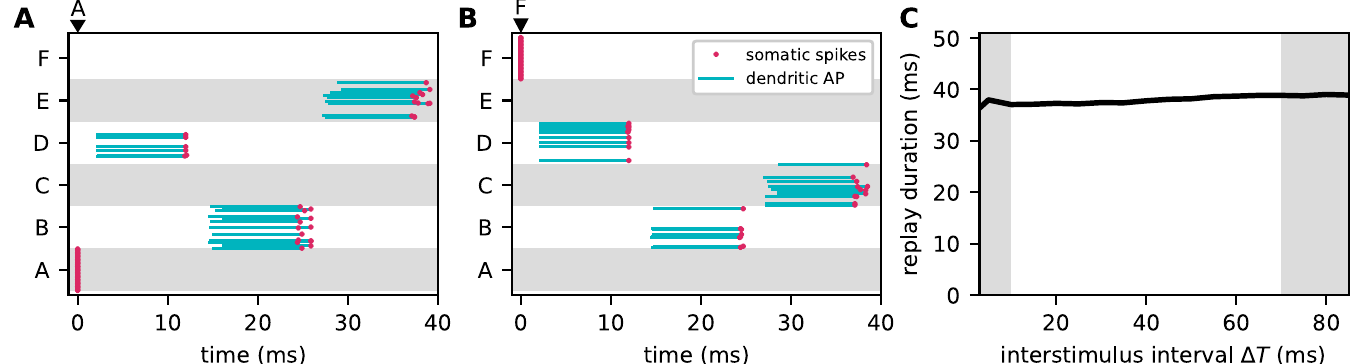
Fig 11. Sequence replay dynamics and speed. Autonomous replay of the sequences {A, D, B, E} ( A ) and {F, D, B, C} ( B ), initiated by stimulating the subpopulations “A” and “F”, respectively. Red dots and blue lines mark somatic spikes and dAP plateaus, respectively, for a fraction of neurons (30%) within each subpopulation. During learning, the inter-stimulus interval Δ T is set to 40 ms. C) Dependence of the sequence replay duration on the inter-stimulus interval Δ T during learning. Replay duration is measured as the difference between the mean firing times of the populations representing the first and last elements in a given sequence. Gray areas mark regions with low prediction performance (see Dependence of prediction performance on the sequence speed). Error bands represent the mean ± standard deviation of the prediction error across 5 different network realizations. Same network and training set as in Fig 8.